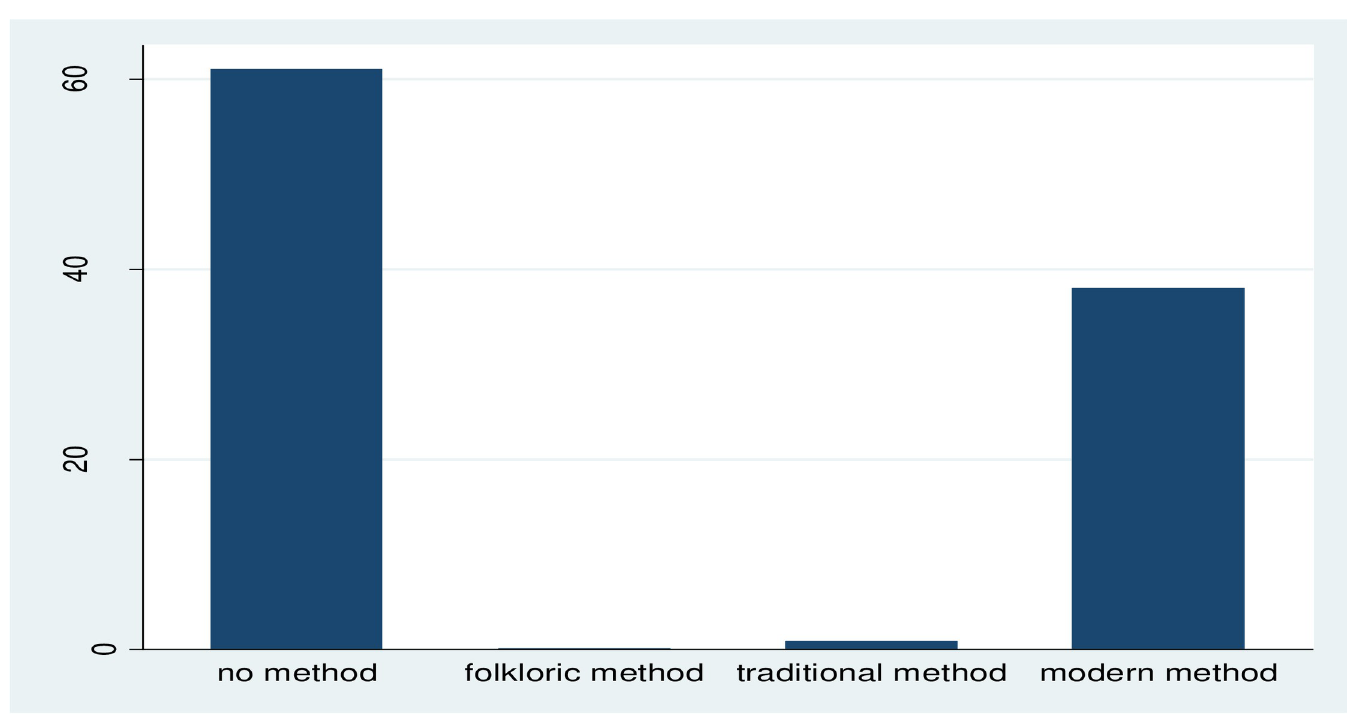
Fig 1. Percentage of current use by contraceptive method type among married women in Ethiopia, EMDHS 2019.